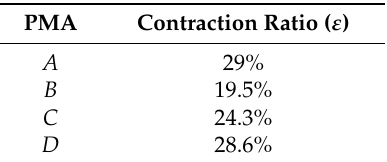
Figure 13. The length of the actuator B with the contraction and elongation curve. Table 6. The contraction ratio of the PMAs.